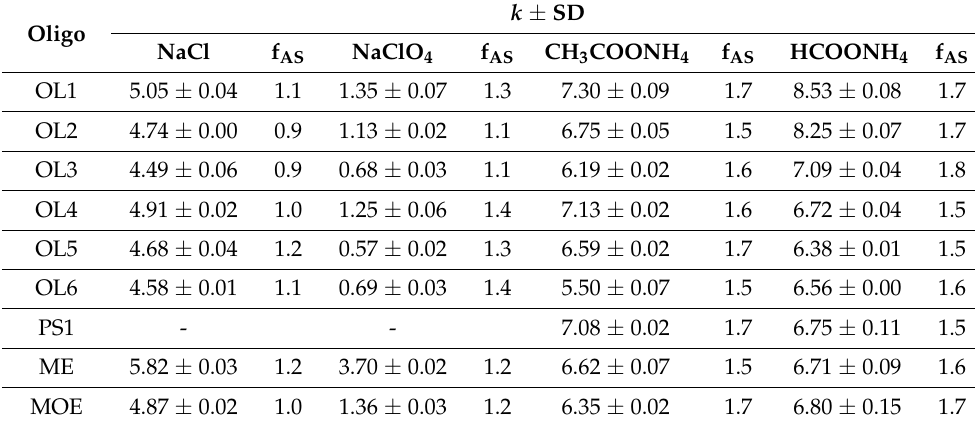
Table 3. The oligonucleotide retention factor ( k ) and asymmetry factor (f AS ) values were obtained for the dendrimeric stationary phase after three reaction cycles and various aqueous solutions of salts in mobile phases (without pH correction). Elution conditions: 0 min—0.125 M of salt, 5 min—0.4 M of salt, 15 min—0.4 M of